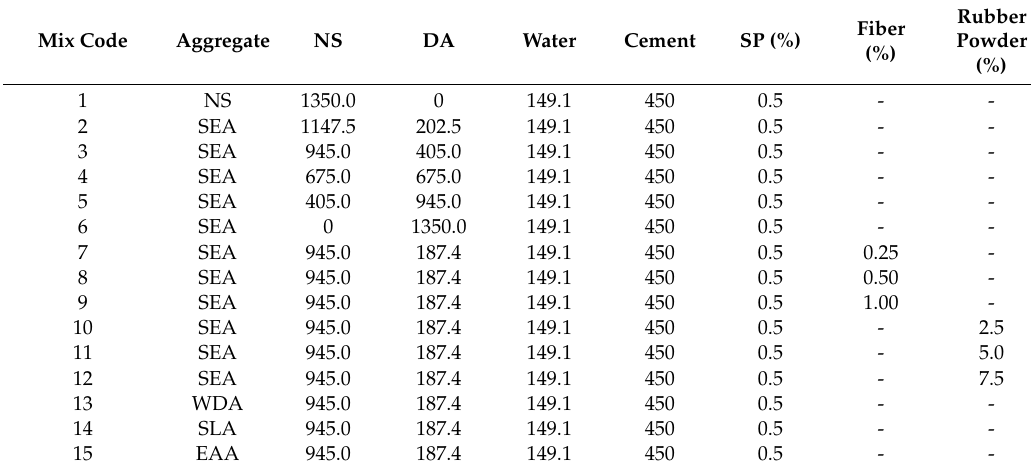
Table 3. Mixture proportions of cement mortar (kg / m 3)